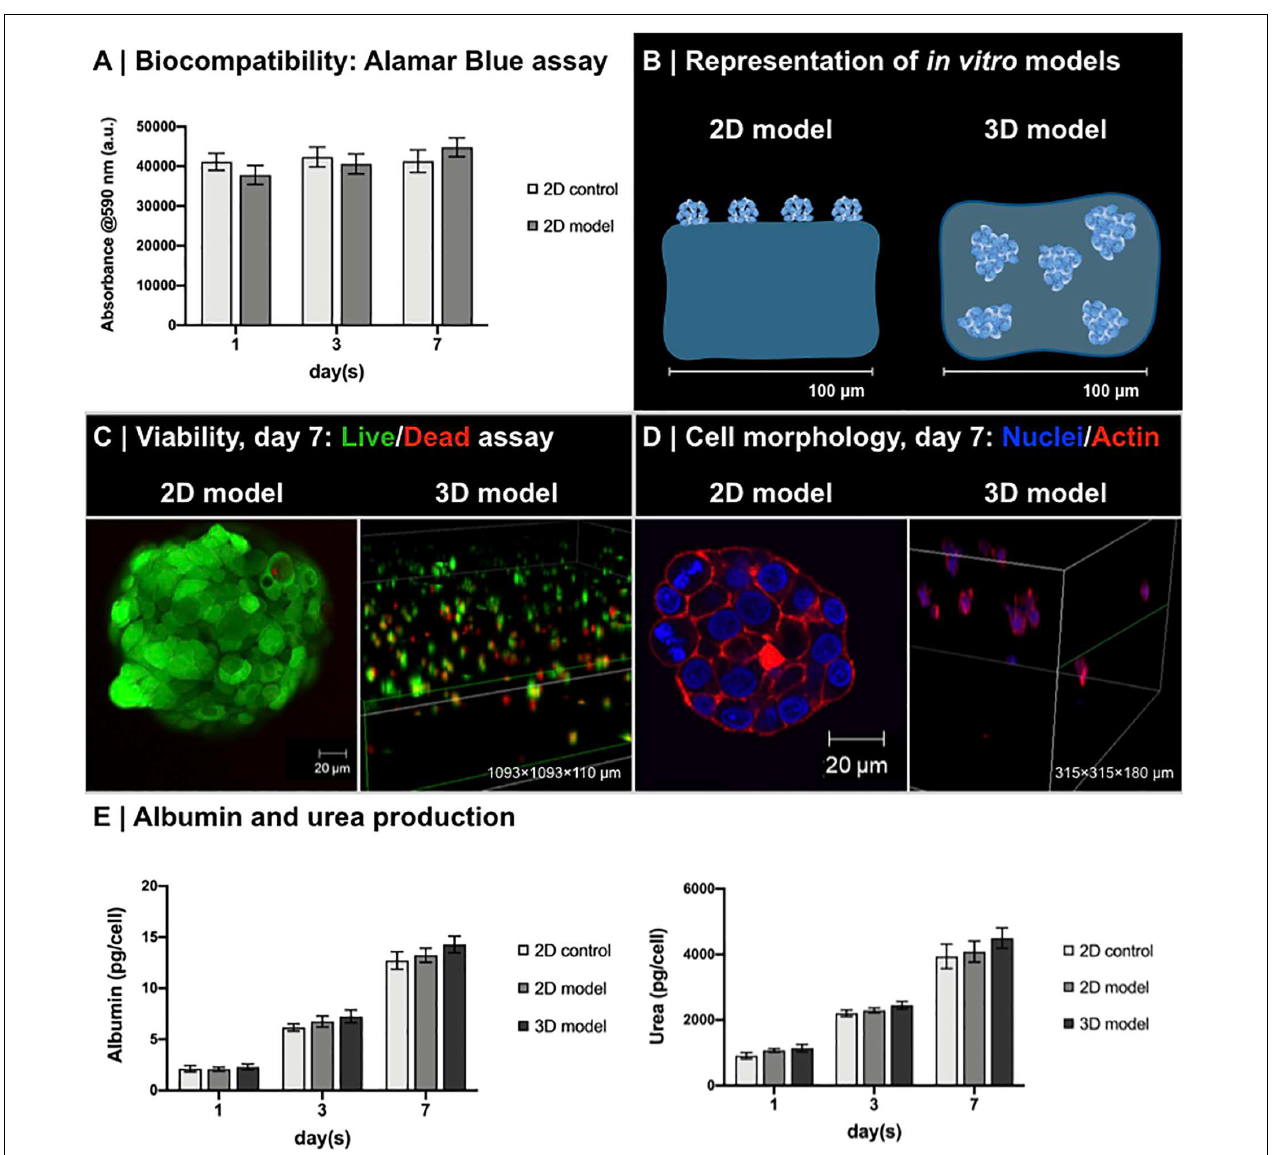
FIGURE 6 | Biocompatibility of enzyme-responsive material. (A) Viability of HepG2 seeded on the top of 0.50 to 0.10 A/DA-NH 2 /A PEGDA (2D model) and collagen gels (2D control). Data are reported as average ± standard deviation ( n = 4 independent experiments). No significant differences were observed at different time points (one-way ANOVA, p < 0.05). (B) Representation of in vitro 2D model and 3D model with HepG2. (C) Live/dead assay of HepG2 in 2D and 3D models. Clusters of live (green) and dead (red) HepG2 cells were observed in both 2D models (detail of HepG2 on 0.50 to 0.10 A/DA-NH 2 /A PEGDA ) and in 3D models (volumetric rendering of HepG2 in 0.50 to 0.10 A/DA-NH 2 /A PEGDA hydrogels, large view). (D) HepG2 morphology in 2D and 3D models. Immunofluorescence staining for cell nuclei (DAPI, blue) and F-actin filaments (phalloidin, red): clusters of HepG2 were observed in both 2D models (detail of HepG2 on 0.50 to 0.10 A/DA-NH 2 /A PEGDA ) and in 3D models (volumetric rendering of HepG2 in 0.50 to 0.10 A/DA-NH 2 /A PEGDA hydrogels, large view). (E) Albumin and urea production normalized against the number of HepG2 over time for 2D model and 3D model. Collagen gels with HepG2 seeded on the top were used as a control (2D control). Data are reported as average ± standard deviation ( n = 4 independent experiments). No significant differences were observed at different time points (one-way ANOVA, p < 0.05). Of note, albumin was produced with an average rate of 1.99 ± 0.16 pg/cell per day (2D control), 2.07 ± 0.18 pg/cell per day (2D model), and 2.25 ± 0.19 pg/cell per day (3D model), whereas urea was produced with an average rate of 736.57 ± 174.56 pg/cell per day (2D control), 806.68 ± 246.89 pg/cell per day (2D model), and 866.70 ± 253.41 pg/cell per day (3D model). Production rates of both albumin and urea were similar in the models tested with respect to